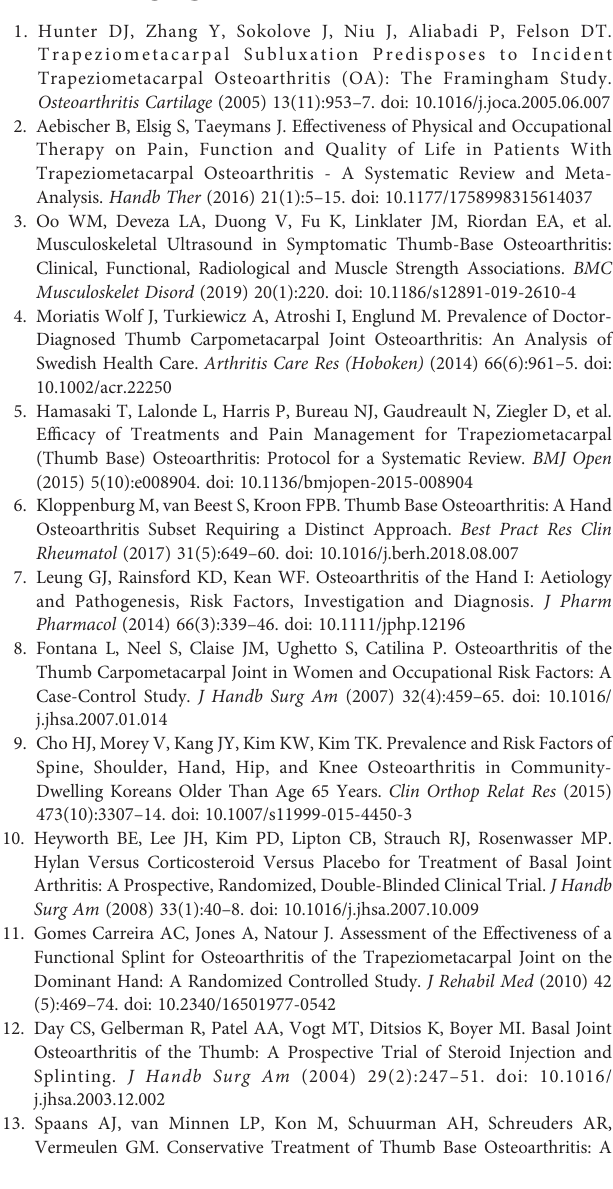
Supplementary Table 2 | PROM are not associated with systemic cytokine expression. After adjusting for age, sex, BMI, and painful joint count, there were no signi fi cant associations between Patient Reported Outcome Measures and systemic cytokine expression in surgical or non-surgical patient groups at baseline (n=44 non-surgical, 39 surgical, Wilcoxon Test, q > 0.1), in either the quick DASH, VAS, or TASD (total, symptomatic or disability scores). Supplementary Table 3 | Clinical Function is not associated with systemic cytokine expression. After adjusting for age, sex, BMI, and painful joint count, there were no signi fi cant associations between clinical function and systemic cytokine expressioninsurgicalornon-surgicalpatientgroupsatbaseline(n=44non-surgical, 39 surgical, Wilcoxon Test, q > 0.1), in key pinch strength.